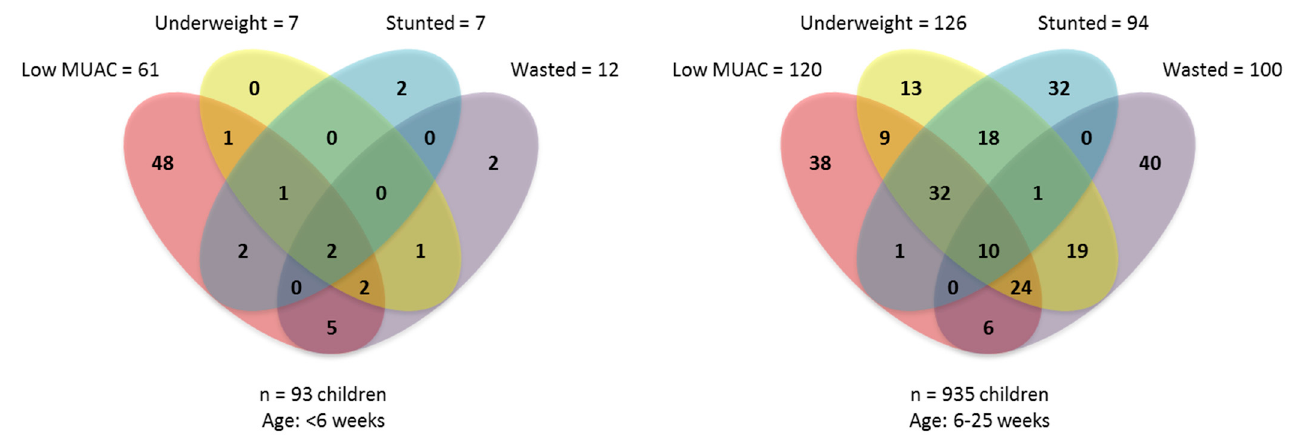
Figure 3. A Venn-diagram showing the overlap of different malnutrition indicators in two age groups. Low MUAC was defined as MUAC < 11.0 cm if <6 weeks, <11.5 thereafter. Underweight, stunted and wasted was defined as weight-for-age, length-for-age and weight-for-length z-scores < − 2, respectively. MUAC: Mid-upper arm circumference.